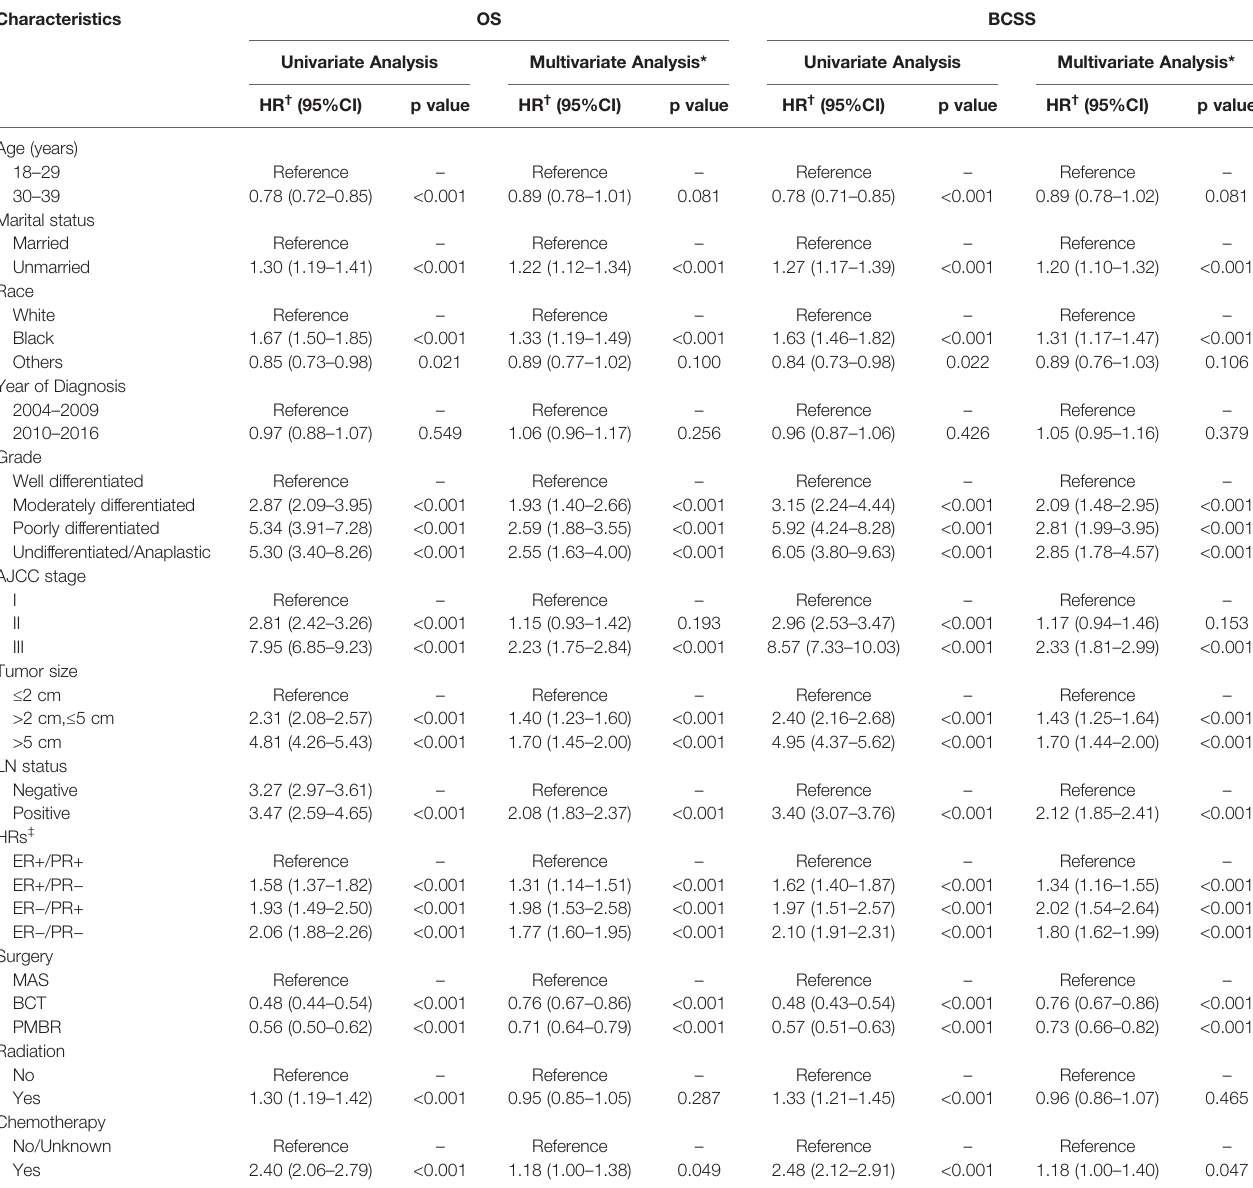
TABLE 4 | Univariate and multivariate analysis of OS and BCSS for young women with operable breast cancer diagnosed between 2004 and 2016.